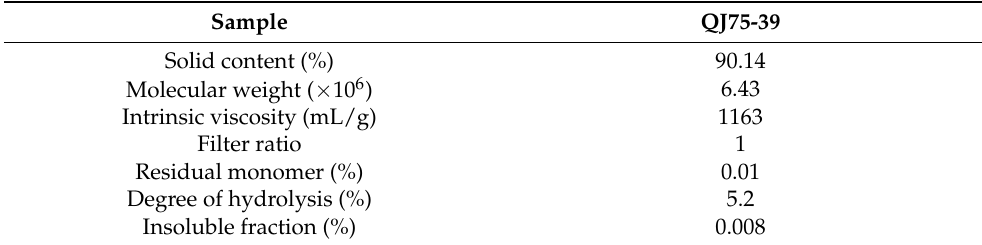
Table 5. Summary of physical and chemical properties.